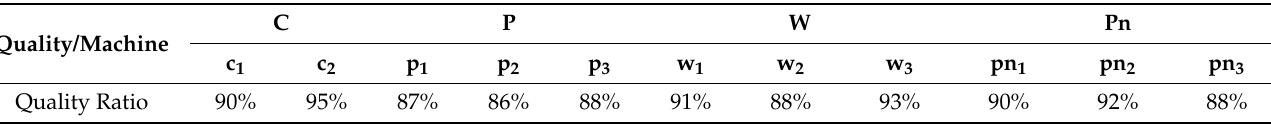
Table 15. Quality coefficient of the machines of the case study.